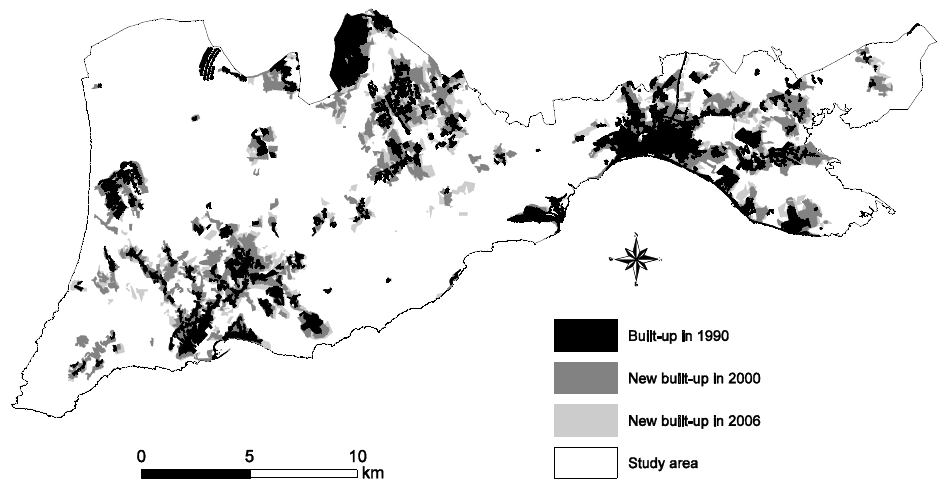
Figure 2. Urban land cover changes between 1990 and